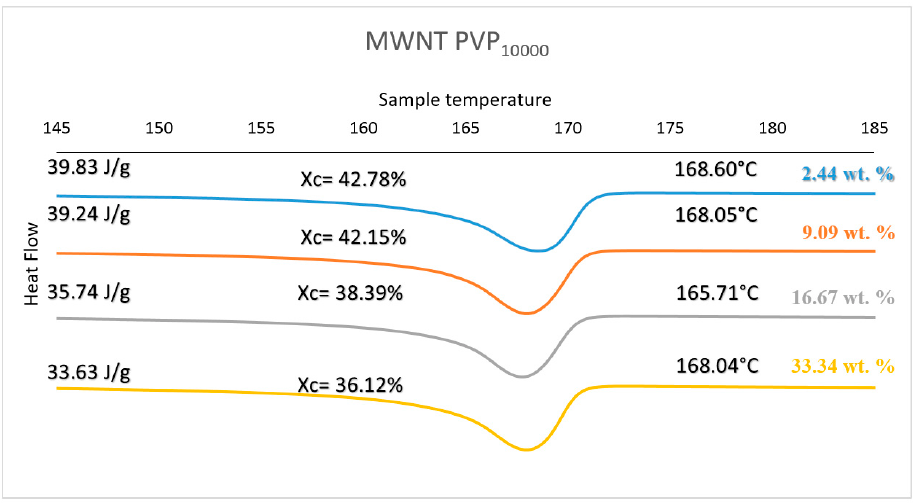
Figure 5. Thermal Properties of PVP 10000 functionalised MWNT/PVDF composite.